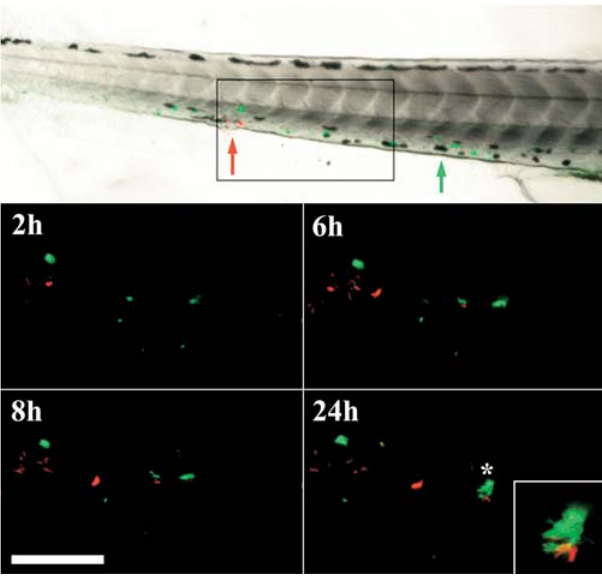
Figure 7. Superinfection with WT Bacteria Rescues D RD1 Aggregation Defect over Time Embryos were injected with fluorescent D RD1 (green) at 1 d postfertilization. 3 d post-primary infection, embryos were injected with fluorescent WT (red) and followed for 24 h post-secondary infection. Approximate injection sites are shown with green and red arrows for D RD1 and WT bacteria, respectively. Box in top panel indicates the magnified field in fluorescent images. Inset panel at 24-h time point is a magnified image of the starred aggregate. Scale bar, 125 l m. DOI: 10.1371/journal.pbio.0020367.g007 Figure 8. Macrophage Aggregation Correlates with Bacterial Dissem-